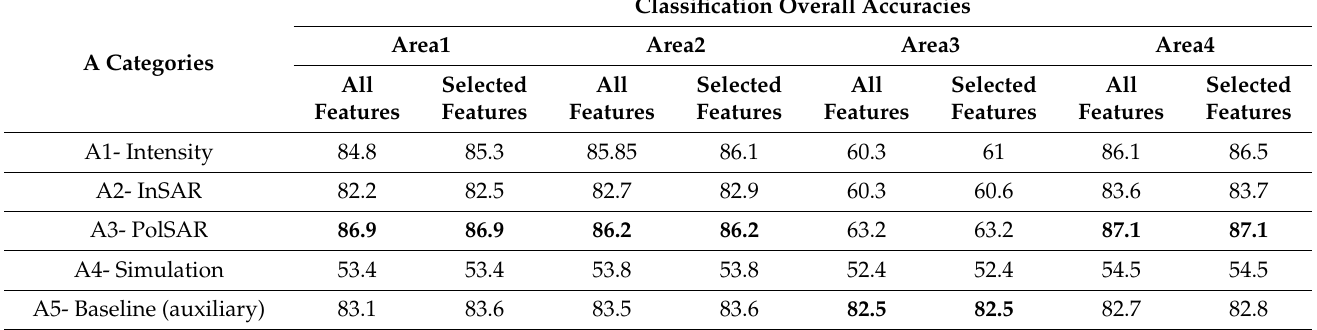
Table 8. Acquired classification accuracies of A Categories: “All” columns indicate the accuracies where all features were included while “selected features” columns show the best accuracies achieved in each category using the selected features.